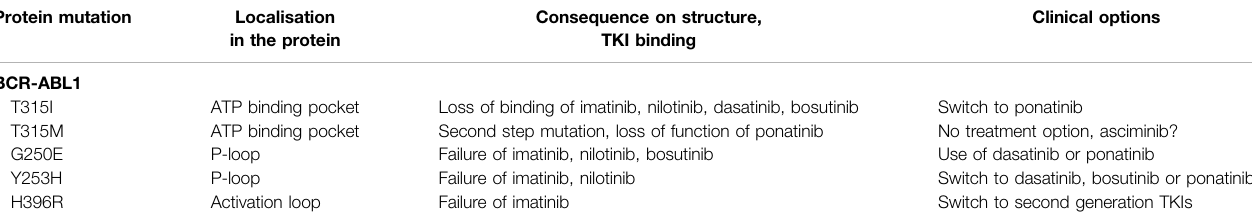
TABLE 2 | Examples of mutations in the BCR-ABL1 protein and their in fl uence on TKI response in CML. Protein mutation